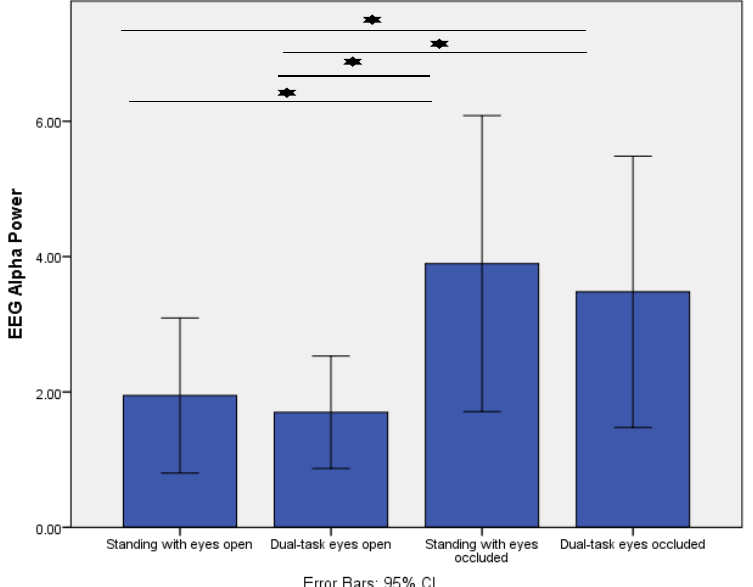
Figure 3. Comparison of posterior EEG alpha power ( µ V 2 /Hz) across the four different standing conditions. * indicates p < 0.01. In addition, increasing task difficulty resulted in changes in the fronto-central EEG theta/beta ratio ( p = 0.01). Post-hoc analysis revealed that the fronto-central theta/beta ratio significantly increased from standing with eyes open to dual-task eyes open ( p = 0.008) and to dual-task eyes occluded ( p = 0.02) (Figure 4).